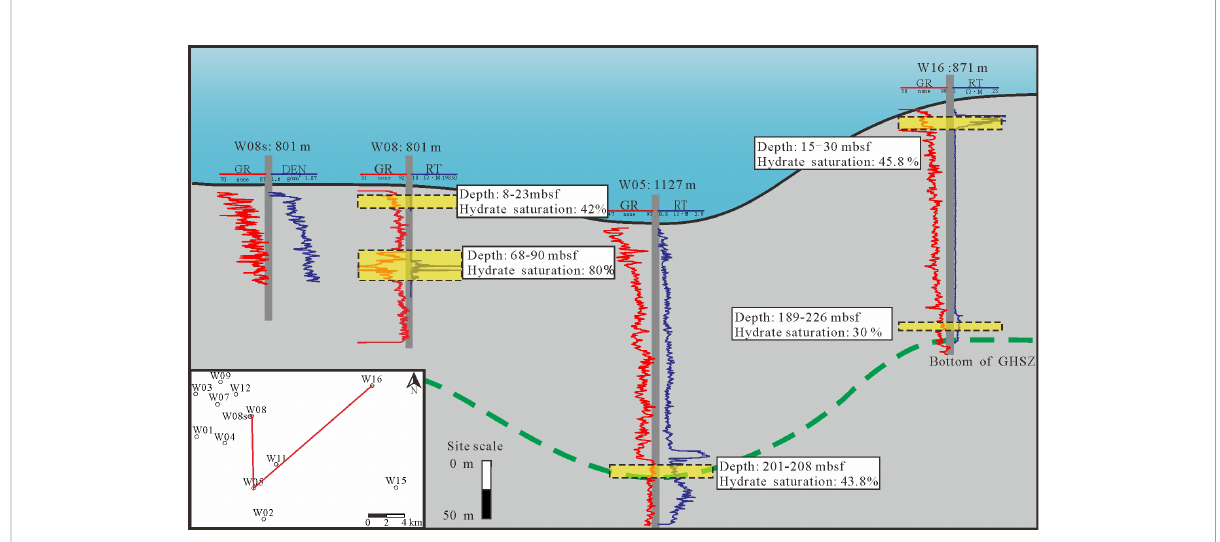
FIGURE 9 Distribution characteristics of single site hydrate in the Dongsha region (data resource: Zhang et al., 2014b; Wang, 2016).